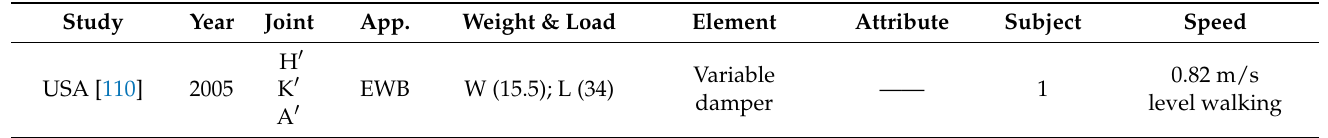
Table 6. Quasi-passive lower limb multi-joint assisted